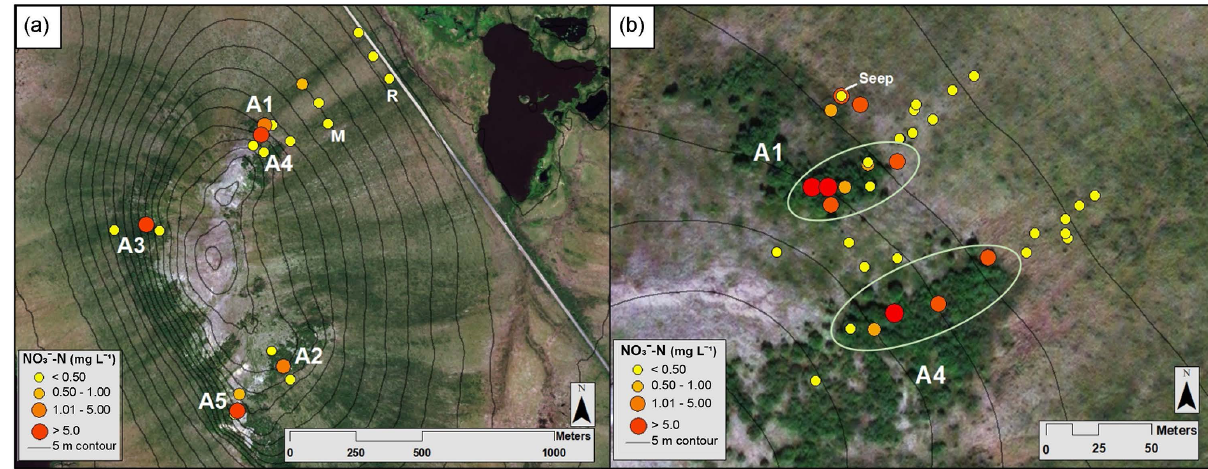
Figure 2. Map of mean NO 3 -N concentrations from the Phase 1 and 2 sampling locations, where yellow indicates low concentrations and red indicates high concentrations (see the key for ranges; scales differ slightly). (a) Circles represent NO 3 -N concentrations at locations along the A1–A5, middle, and road transects in July 2017. (b) Dots represent average NO 3 -N concentrations along the A1 and A4 transects and between the transects over all sampling campaigns. The green ellipses indicate samples collected within the alder shrubland, as opposed to outside the alder shrubland. Aerial imagery in this figure is sourced from Esri, DigitalGlobe, GeoEye, Earthstar Geographics, CNES/Airbus DS, USDA, USGS, AeroGRID, IGN, and the GIS User